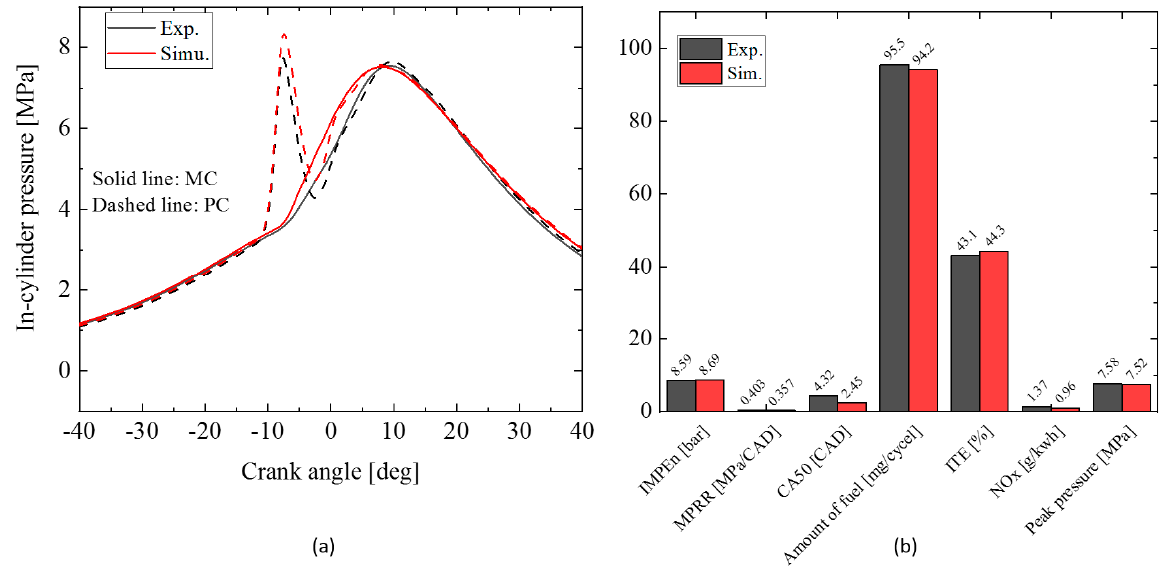
Figure 3. Validation of: ( a ) predicted pressure trace; and ( b ) predicted engine performance parameters for the reference case of Table 2.